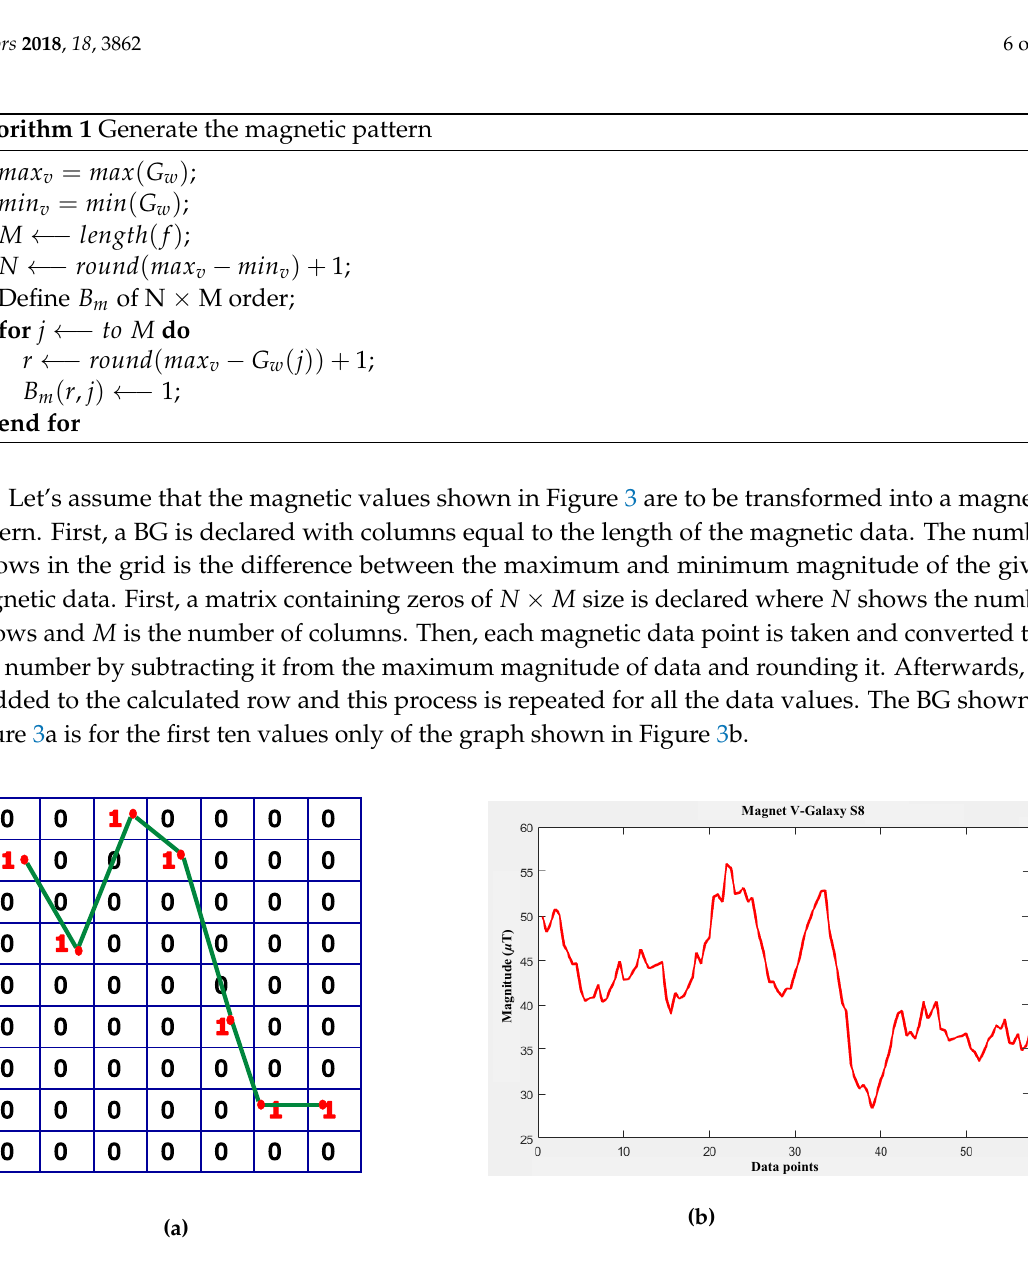
Figure 3. ( a ) Sample binary grid for first 10 data points; ( b ) magnetic field